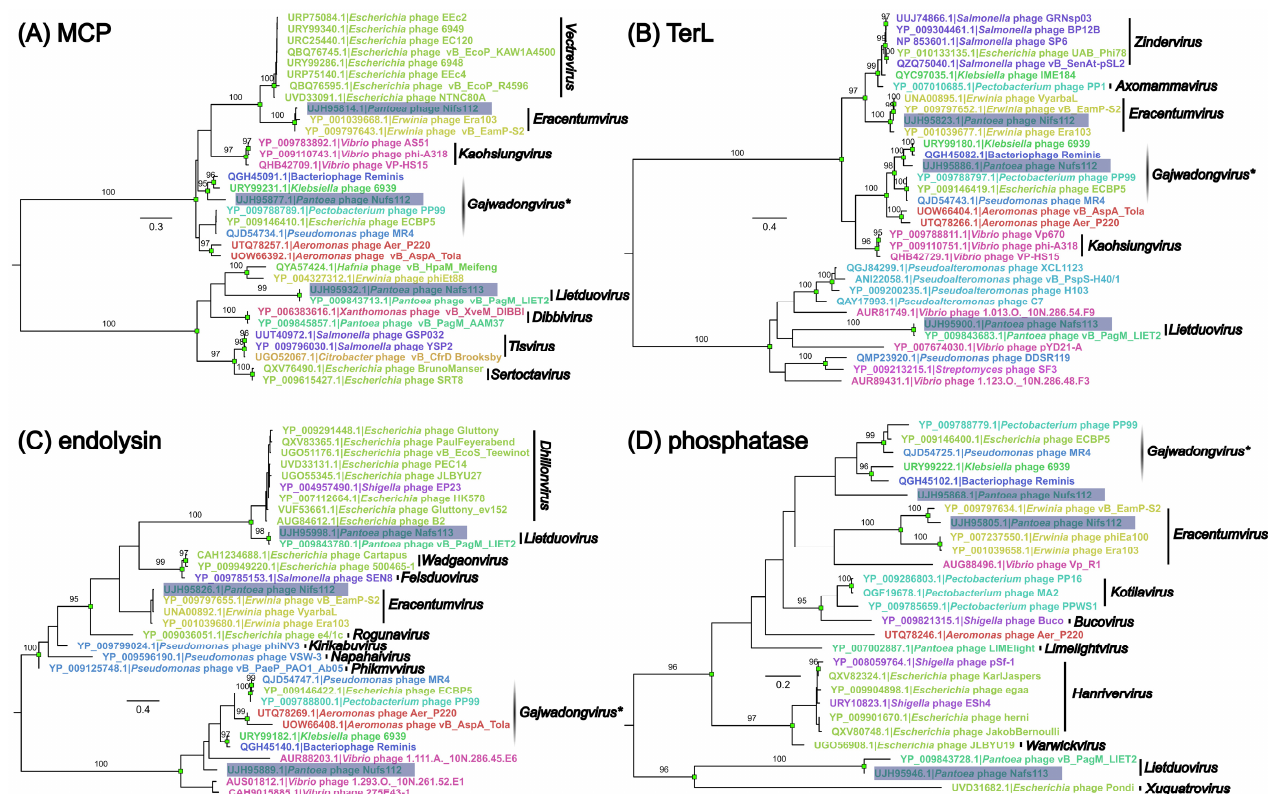
Figure 3. Midpoint-rooted maximum likelihood trees of the selected studied phage protein amino acid sequences and similar sequences found in the proteomes of other cultured phages. ( A ) Major capsid protein (MCP), ( B ) terminase large subunit (TerL), ( C ) endolysin, ( D ) phosphatase dataset; multiple sequence alignment and tree details can be found in Supplementary Table S4. The trees are drawn to their respective scales, and branch lengths correspond to the number of amino acid substitutions per site. Branches with UFBoot support of ≥ 95% (out of 1000 replicates) have their distal nodes indicated as green rectangles, and the corresponding UFBoot value is indicated above the branches. In all of the trees, tips are labeled as “Respective protein accession|Originating phage”, and tip labels are colored based on the respective phage host genus; labels of the leaves containing the amino acid sequences of the respective studied phage proteins are highlighted in blue. Labeled black bars after the tip labels show clade genus level annotations retrieved from the respective phage complete-genome metadata at the time of writing (if indicated). Cloudy black bar labeled “ Gajwadongvirus *” indicates dubious genus-level designation for some of the phages and contains some phages without genus-level associated taxonomy